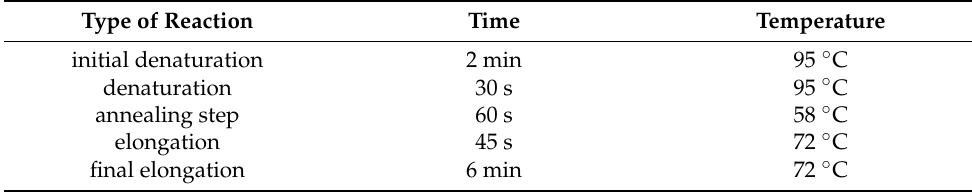
Table 1. Thermal profile of the first, outer amplification reaction (40 cycles from 2 to 4). Type of